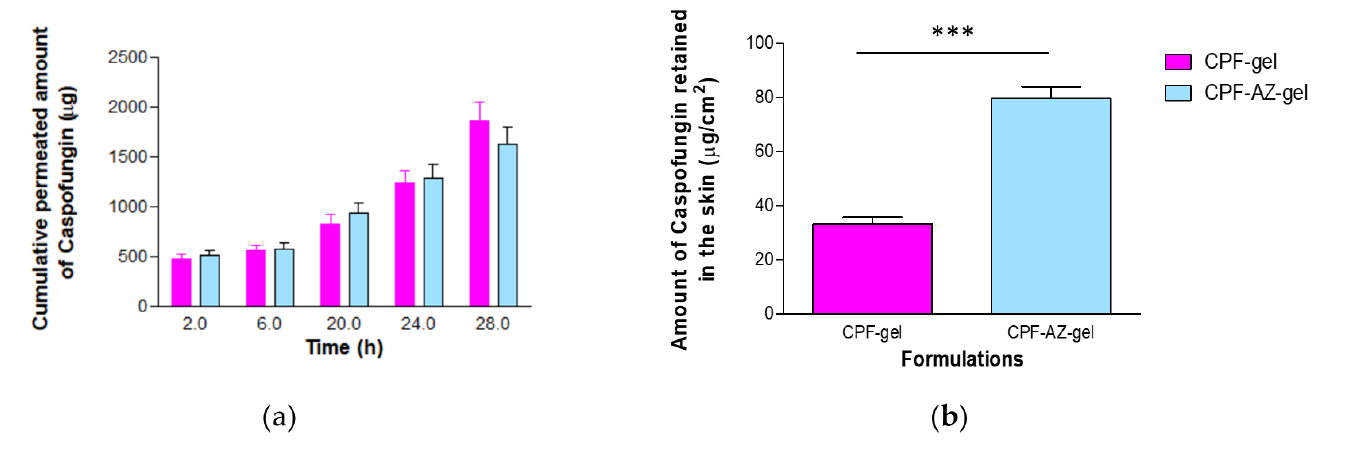
Figure 11. Permeation of caspofungin from CPF-gel and CPF-AZ-gel: ( a ) permeation profiles of caspofungin depicted as the cumulative amounts of caspofungin permeated through the ex vivo skin over time; ( b ) amount of caspofungin remaining in the skin at the end of the permeation study (28 h). *** significant statistical differences between the two gels ( p < 0.0001).